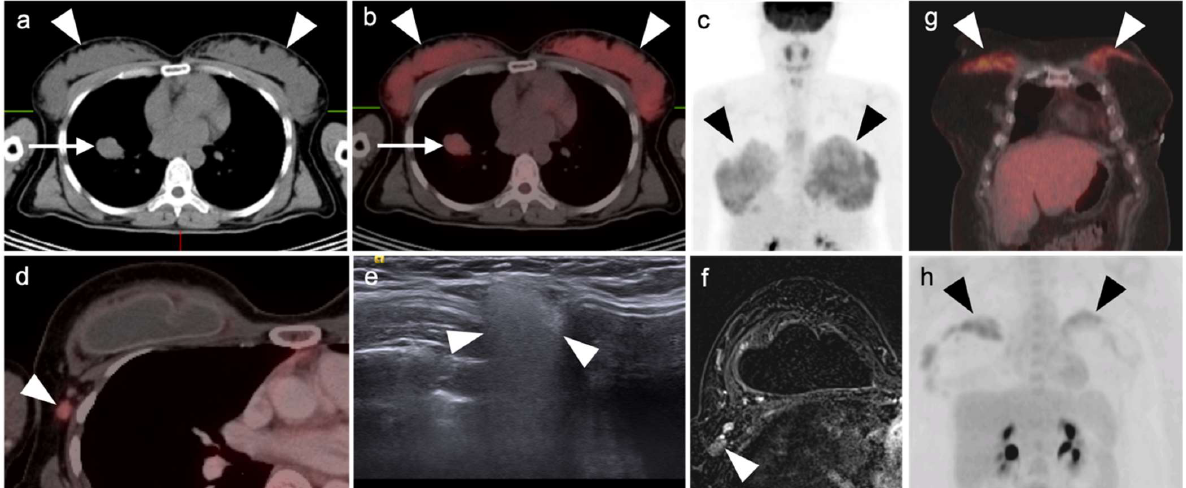
Figure 17. Non-malignant breast conditions. ( a – c ) Lactating breasts. ( a ) Lactating breast tissue is characterized by dense parenchymal tissue on axial CT ( white arrowheads ); ( b ) Axial FDG PET-CT shows increased metabolic activity in the dense lactating breast tissue ( white arrowheads ); ( c ) MIP FDG PET image shows bilateral dense hypermetabolic breast parenchyma typical with lactation. The right lung mass ( white arrow ) was a bronchial carcinoid tumor (successfully removed); The bronchial carcinoid is also metabolically active ( white arrow ); ( c ) FDG PET MIP image shows the hypermetabolic lactating breast tissue ( black arrowheads ); ( d – f ) Silicone granuloma. ( d ) Axial FDG PET-CT of the right breast shows a partially collapsed right breast implant with an enlarged hypermetabolic right axillary node ( white arrowhead ), a silicone granuloma. ( e ) Ultrasound of the right axillary node demonstrates a typical heterogeneous “snowstorm” sign of a silicone granuloma with posterior acoustic shadowing ( white arrowheads ). ( f ) Silicone specific STIR sequence MRI image demonstrates high signal intensity in lymph nodes due to presence of silicone ( white arrowhead ); ( g , h ) Fat necrosis. Coronal FDG PET-CT ( g ) and FDG PET MIP ( h ) images demonstrate hypermetabolic soft tissue within the superior margin of tram flap reconstruction following bilateral mastectomies, consistent with fat necrosis. This can remain hypermetabolic